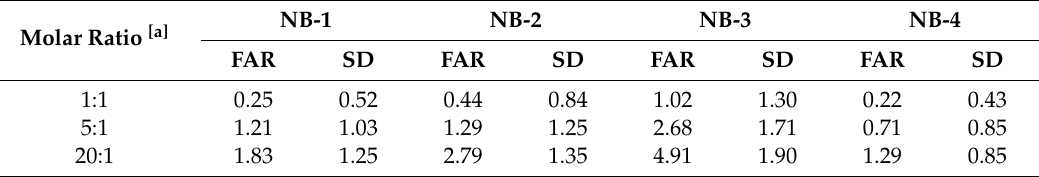
Figure 2. Analysis of isomers in the modified VHHs. ( A ) Native polyacrylamide gel electrophoresis (Native-PAGE) analysis of the modified VHHs. The gels were first visualized under ultraviolet light to get fluorescence signal (gels with black background), after that the gels were stained with Coomassie brilliant blue and visualized white light (gels with white background). Molar ratio (NHS-Fluo:VHH) of each group was labeled upon the lanes. ( B ) Different FAR of isomers in the modified VHH analyzed by LC-MS intact protein analysis. The percentage of isomers was visualized in a percentage accumulation diagram. Molar ratio of each group was labeled upon the histogram. Table 2. Average FAR and standard deviation of the modified